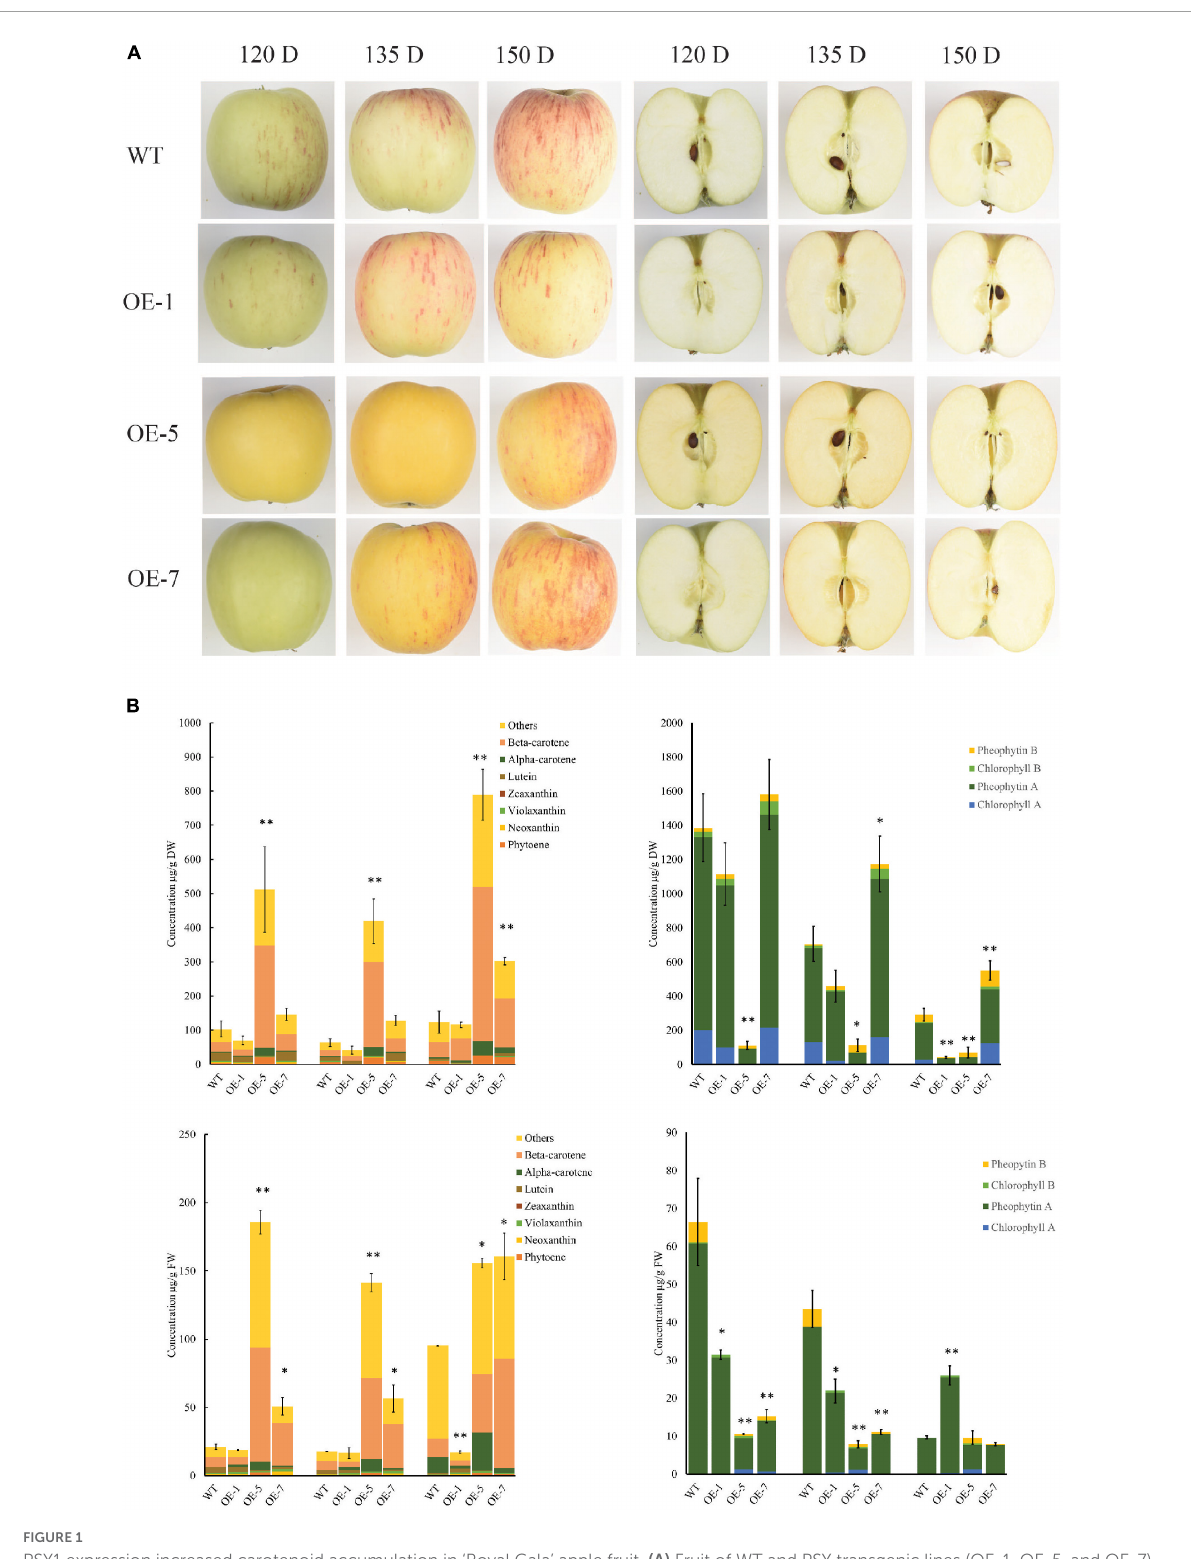
FIGURE1 PSY1 expression increased carotenoid accumulation in ‘Royal Gala’ apple fruit. (A) Fruit of WT and PSY transgenic lines (OE-1, OE-5, and OE-7) at different developmental stages. (B) Bar graphs of carotenoid content measured by HPLC as beta-carotene equivalents (left column) and chlorophyll (right column) in fruit skin (top panel) and fruit flesh (bottom panel) in wild type and transgenic lines OE-1, OE-5, and OE-7. The error bars represent the standard errors of the mean of three biological replicates, with each replicate a pool of 5–7 fruit. Bar graph with asterisk show significant difference from WT at the same fruit stage using Dunnett’s test (* P < 0.05; ** P <